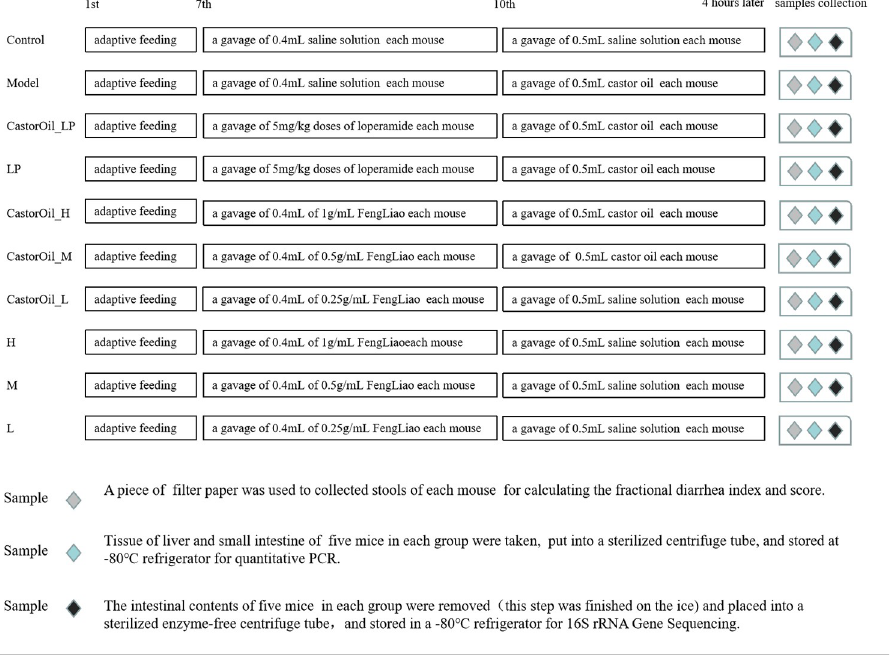
Fig 1. Experimental design and sample